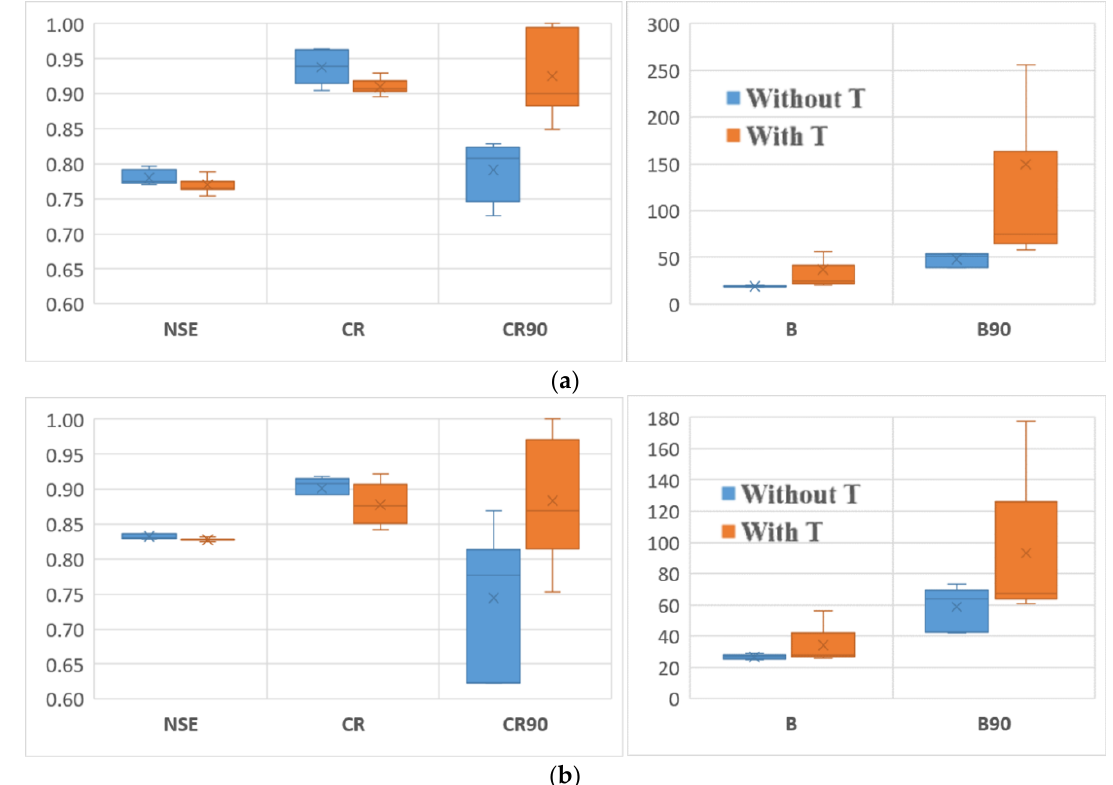
Figure 7. The boxplots of the different evaluation metrics for the BMA streamflow simulations by implementation (With T) or non-implementation of data transformation (without T) methods being derived from considering normal distribution and different proposed standard deviation types for the ( a ) Big East River and ( b ) Black River watersheds during the validation period. Table 5. Probabilistic evaluation criteria of different BMA variants based on different data transformation methods for both watersheds in the validation period B a s i